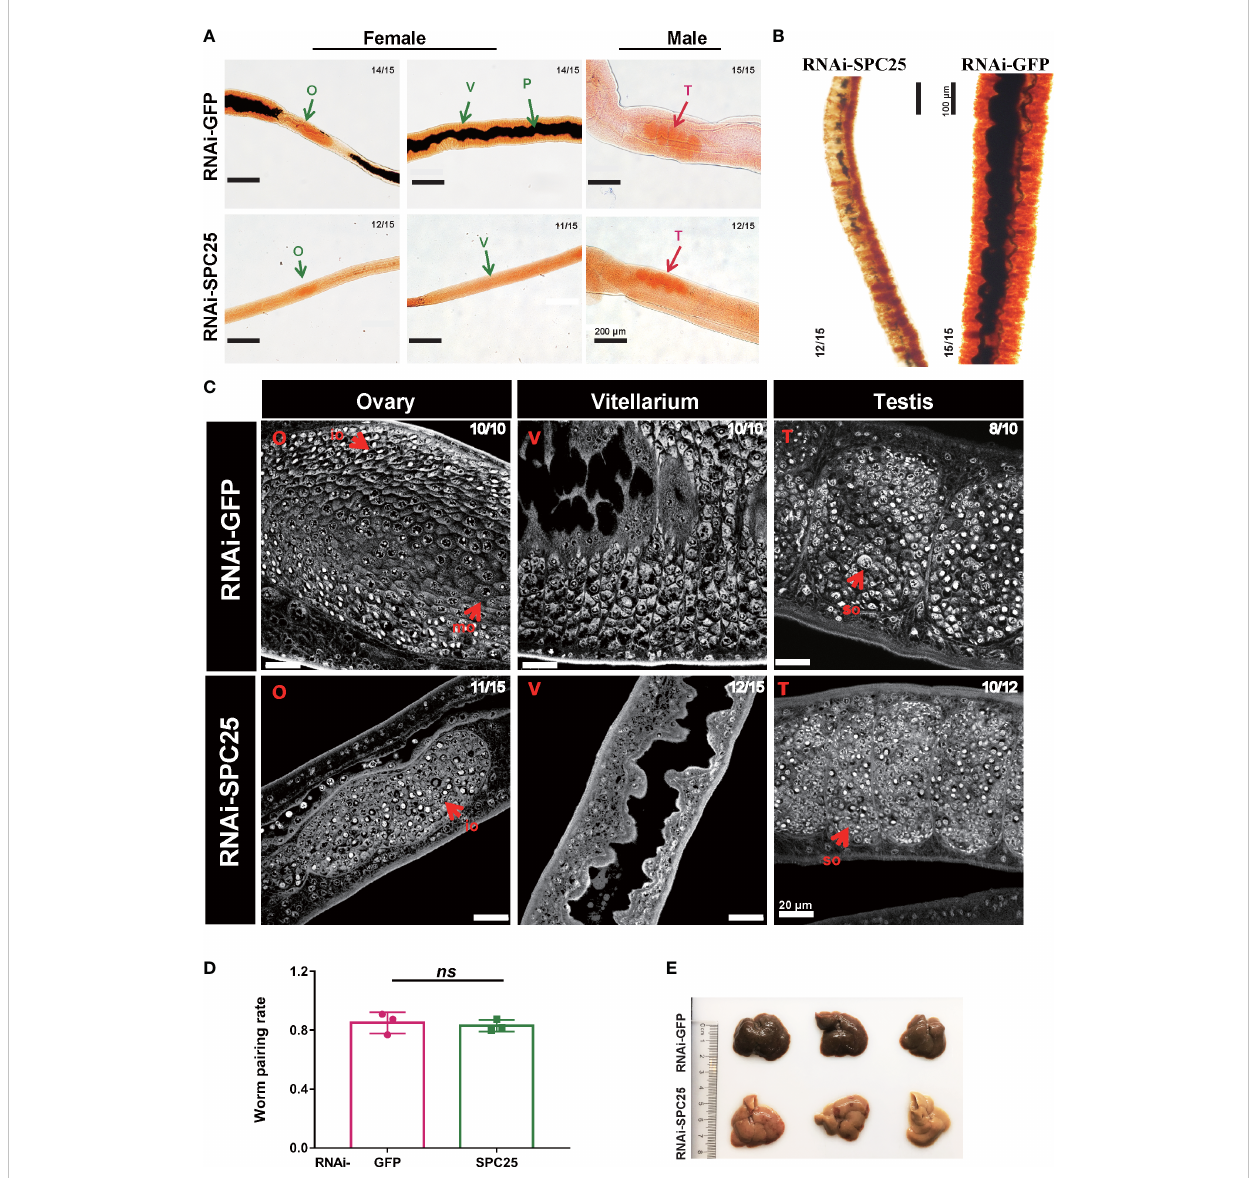
FIGURE 4 Morphological analysis of the reproductive organ in recovered RNAi-SPC25 worms at 30 dpi. (A) Microscopy images of carmalum staining of S. japonicum . (B) Microscopy images of Fast Blue B staining female worm. Positive Fast Blue B staining indicates mature vitelline cells. (C) Confocal laser scanning micrographs documenting morphological changes in the reproductive organs of RNAi-SPC25 group and control group worms. T, testis; O, ovary; V, vitellarium; P, intestinal pigment deposition; mo, mature oocytes; io, immature oocytes; so, spermatocytes. (D) The pairing rates of RNAi-SPC25 and RNAi-GFP worms. Each group had three biological replicates, and the data were shown as means ± SEM. (E) Liver receiving from the mice injected with dsGFP and dsSPC25. X/Y: number of worms with the same phenotype/number of worms analyzed in one biological replicate. ns, not signi fi cant,